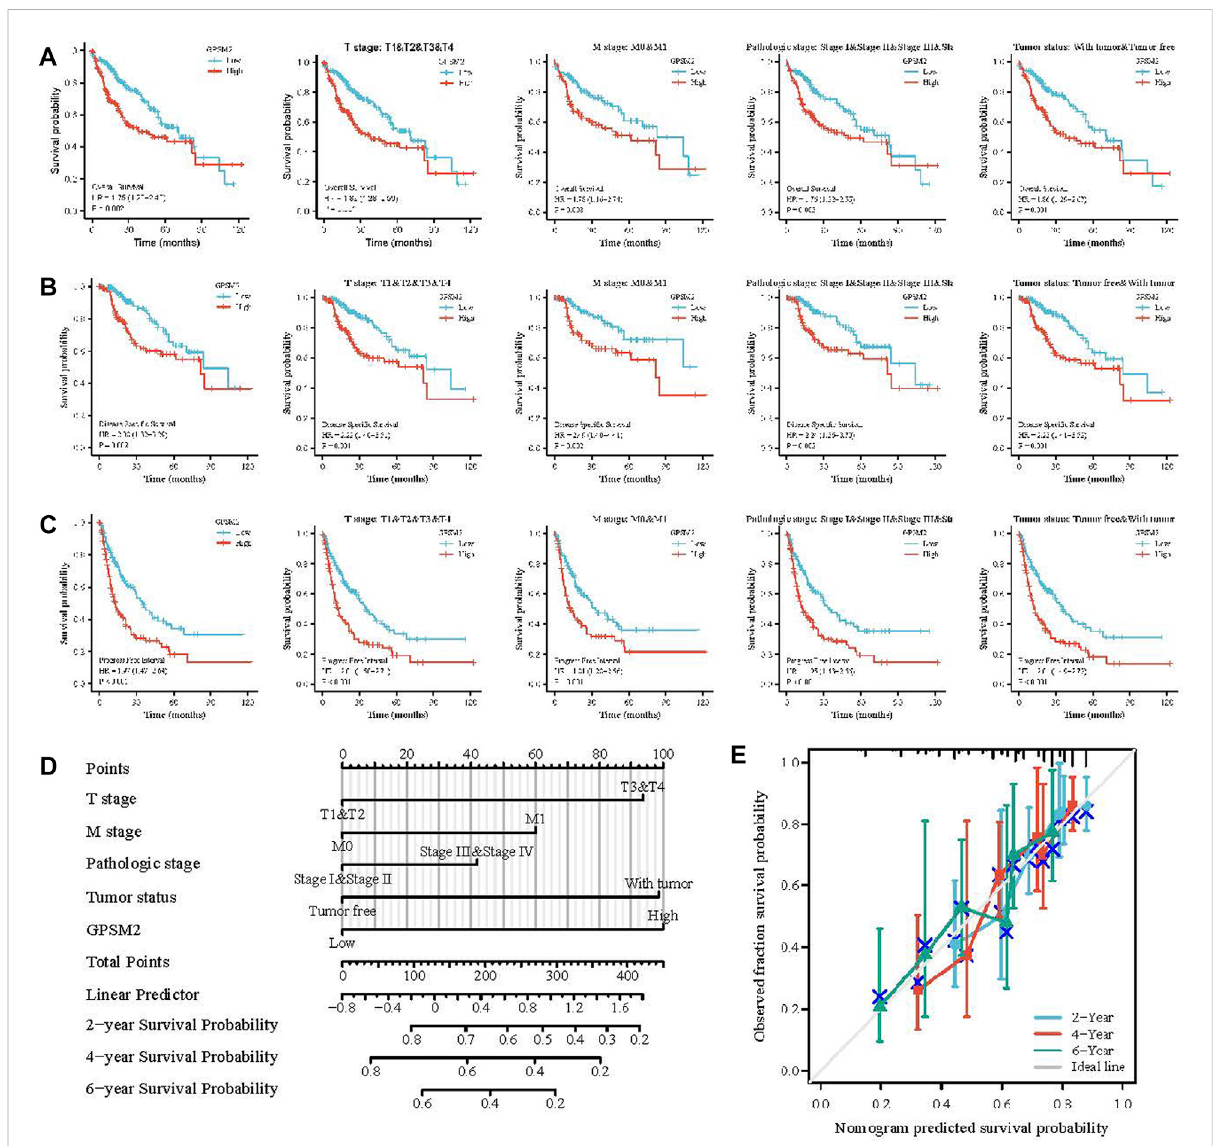
FIGURE 5 Prognosis of GPSM2 in LIHC tumors and GPSM2 prediction model in LIHC patients. (A – C) Correlation between GPSM2 and OS, DSS, and PFI in different clinical subgroups of LIHC. (D) Colinear plots of prognostic predictors and annual survival in LIHC. (E) Colinear calibration